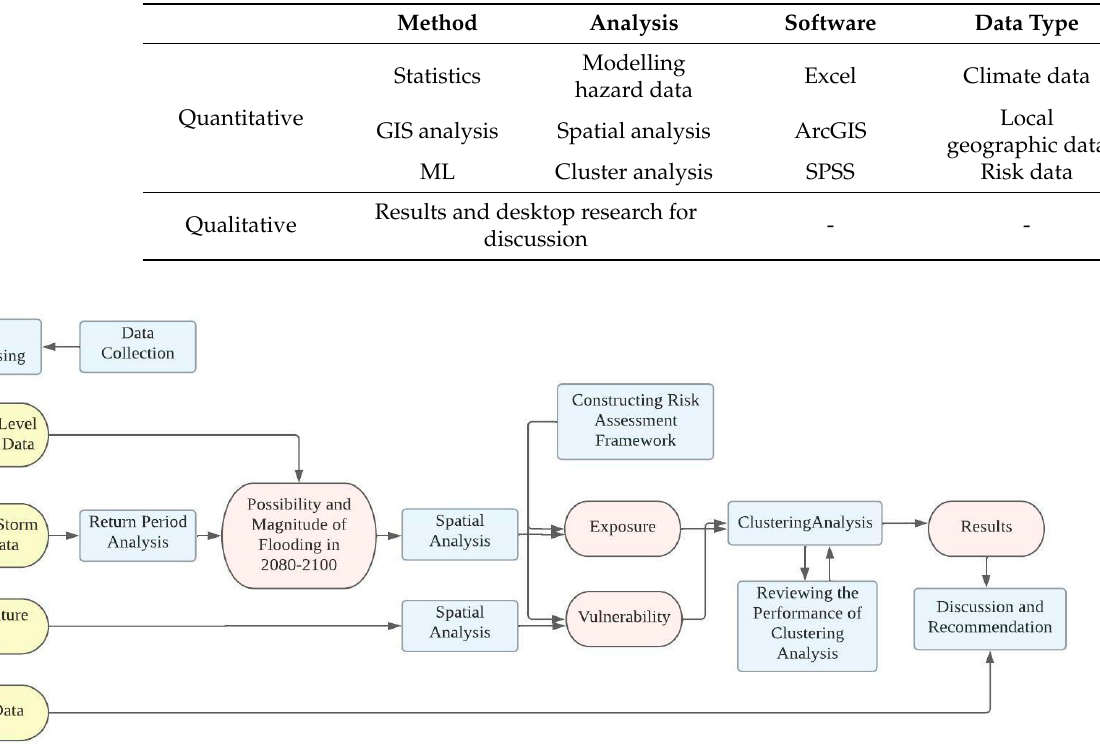
Figure 1. Research flow chart.